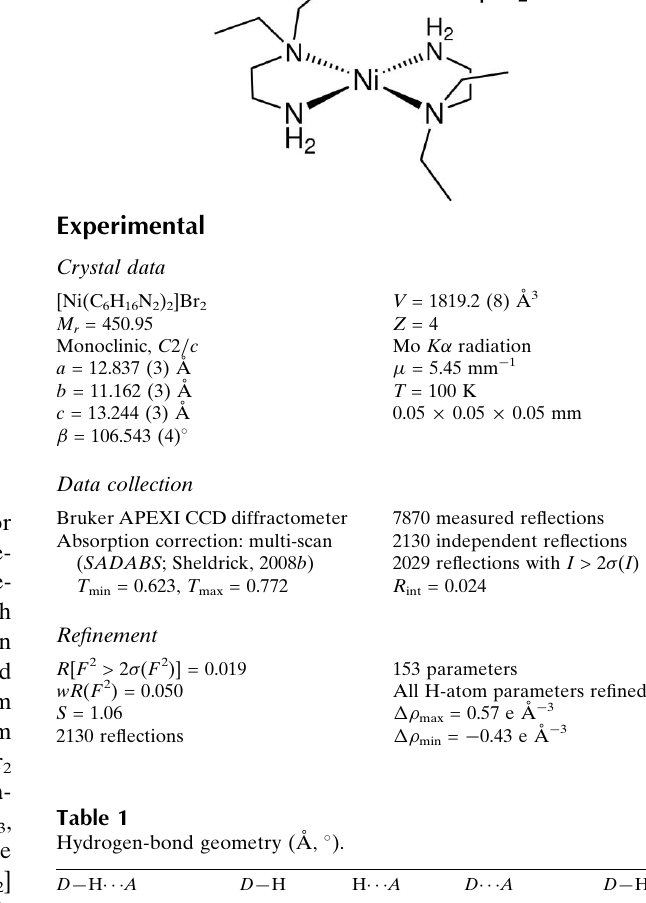
Hydrogen-bond geometry (A˚ , (cid:4) ). D —H (cid:3)(cid:3)(cid:3)